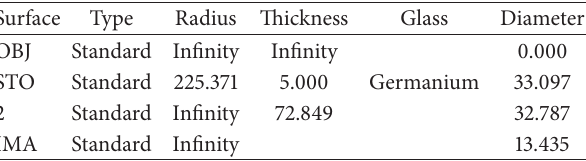
Table 1: Specifications of the refractive lens (mm).